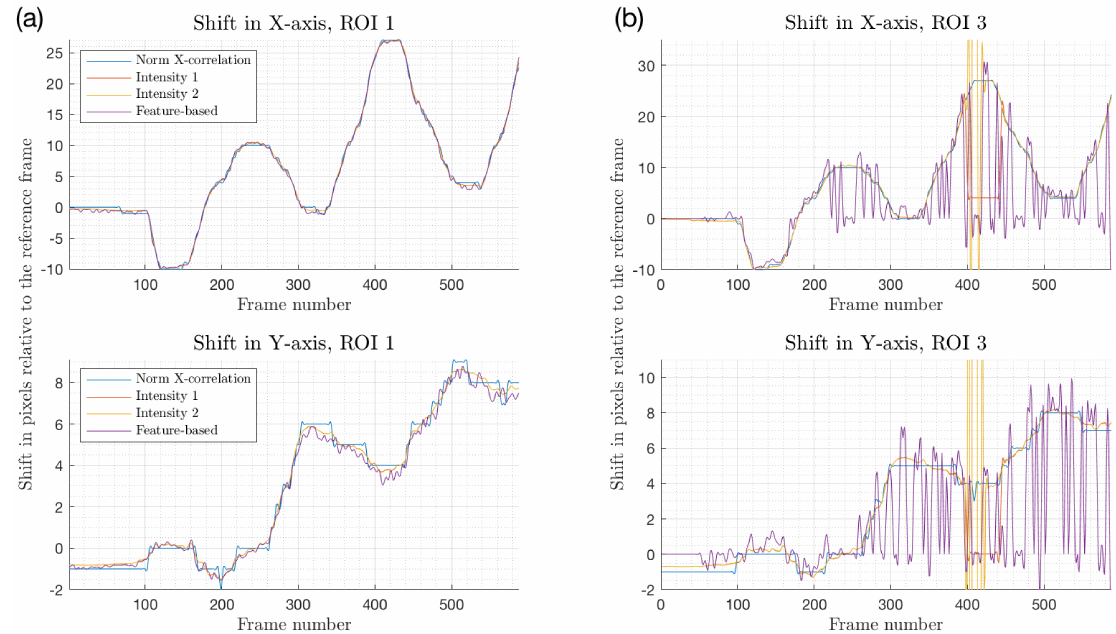
Figure 8. Motion registration results for X and Y axes when applied to ROI 1 ( a ) and ROI 3 ( b ). The ROI size was 341 × 188 pixels (4.6 × 2.54 cm) and 110 × 71 pixels (1.49 × 0.96 cm), respectively. All images in the dataset were (arbitrarily) registered w.r.t. frame #100. Negative values denote motion in the direction opposite to the positive